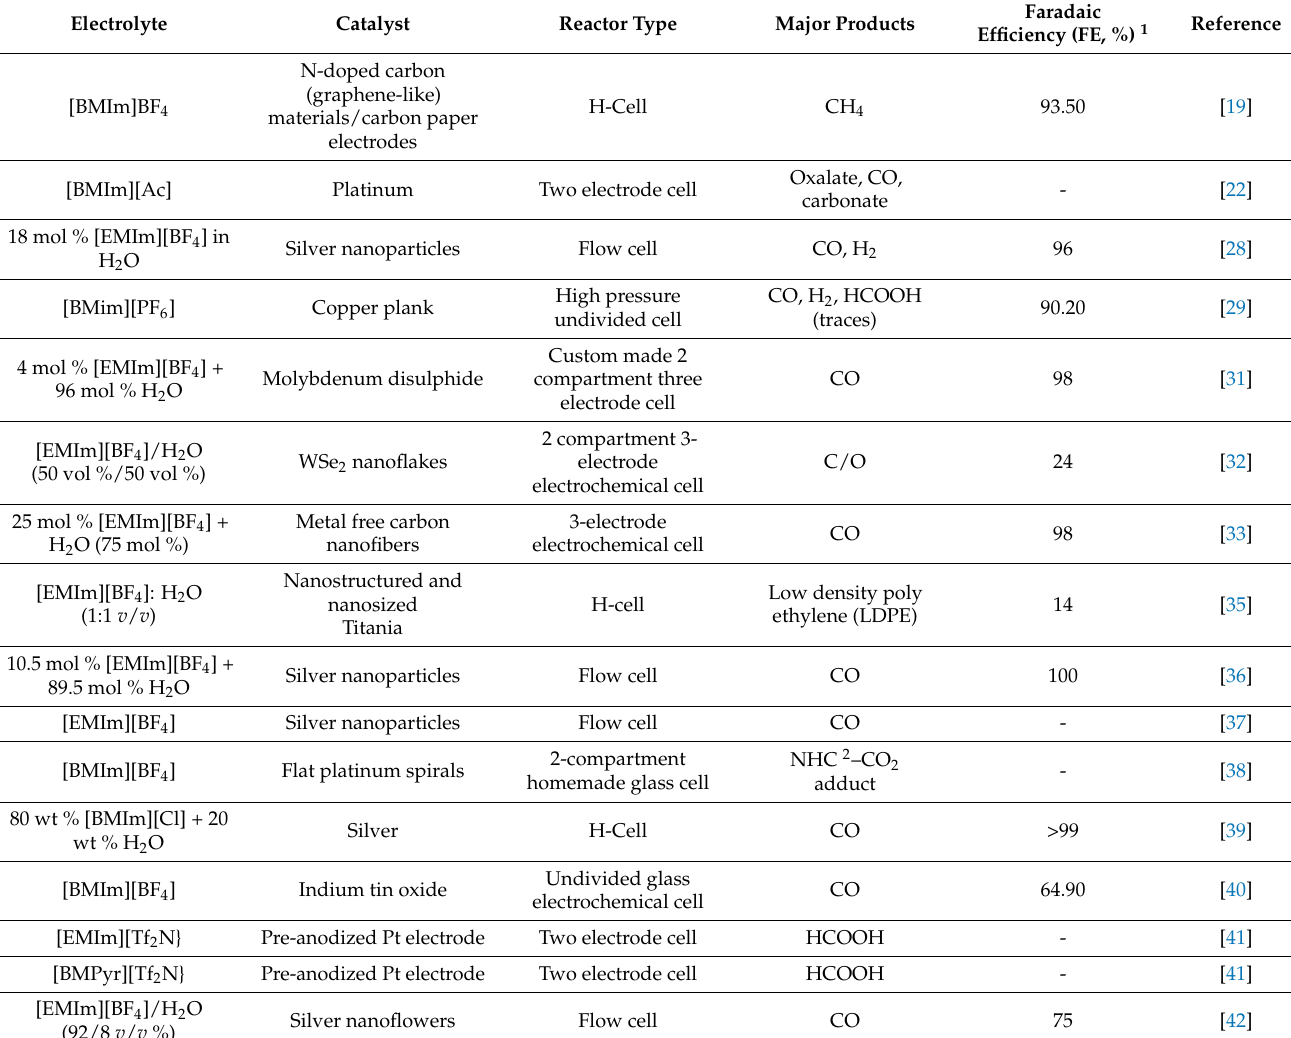
Table 2. Summary of IL -based electrolytes used in the electroreduction of CO 2